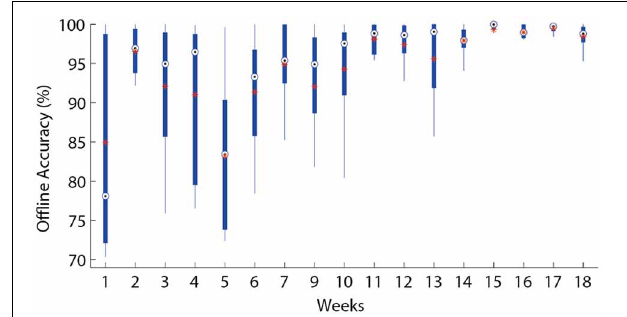
FIGURE 3 | Offline accuracy. The offline discrimination accuracy over time is presented in box plots where the central mark represents the median value; the edges of the box are the 25th and 75th percentiles; the whiskers give the range of data values; “ ∗ ” represent average